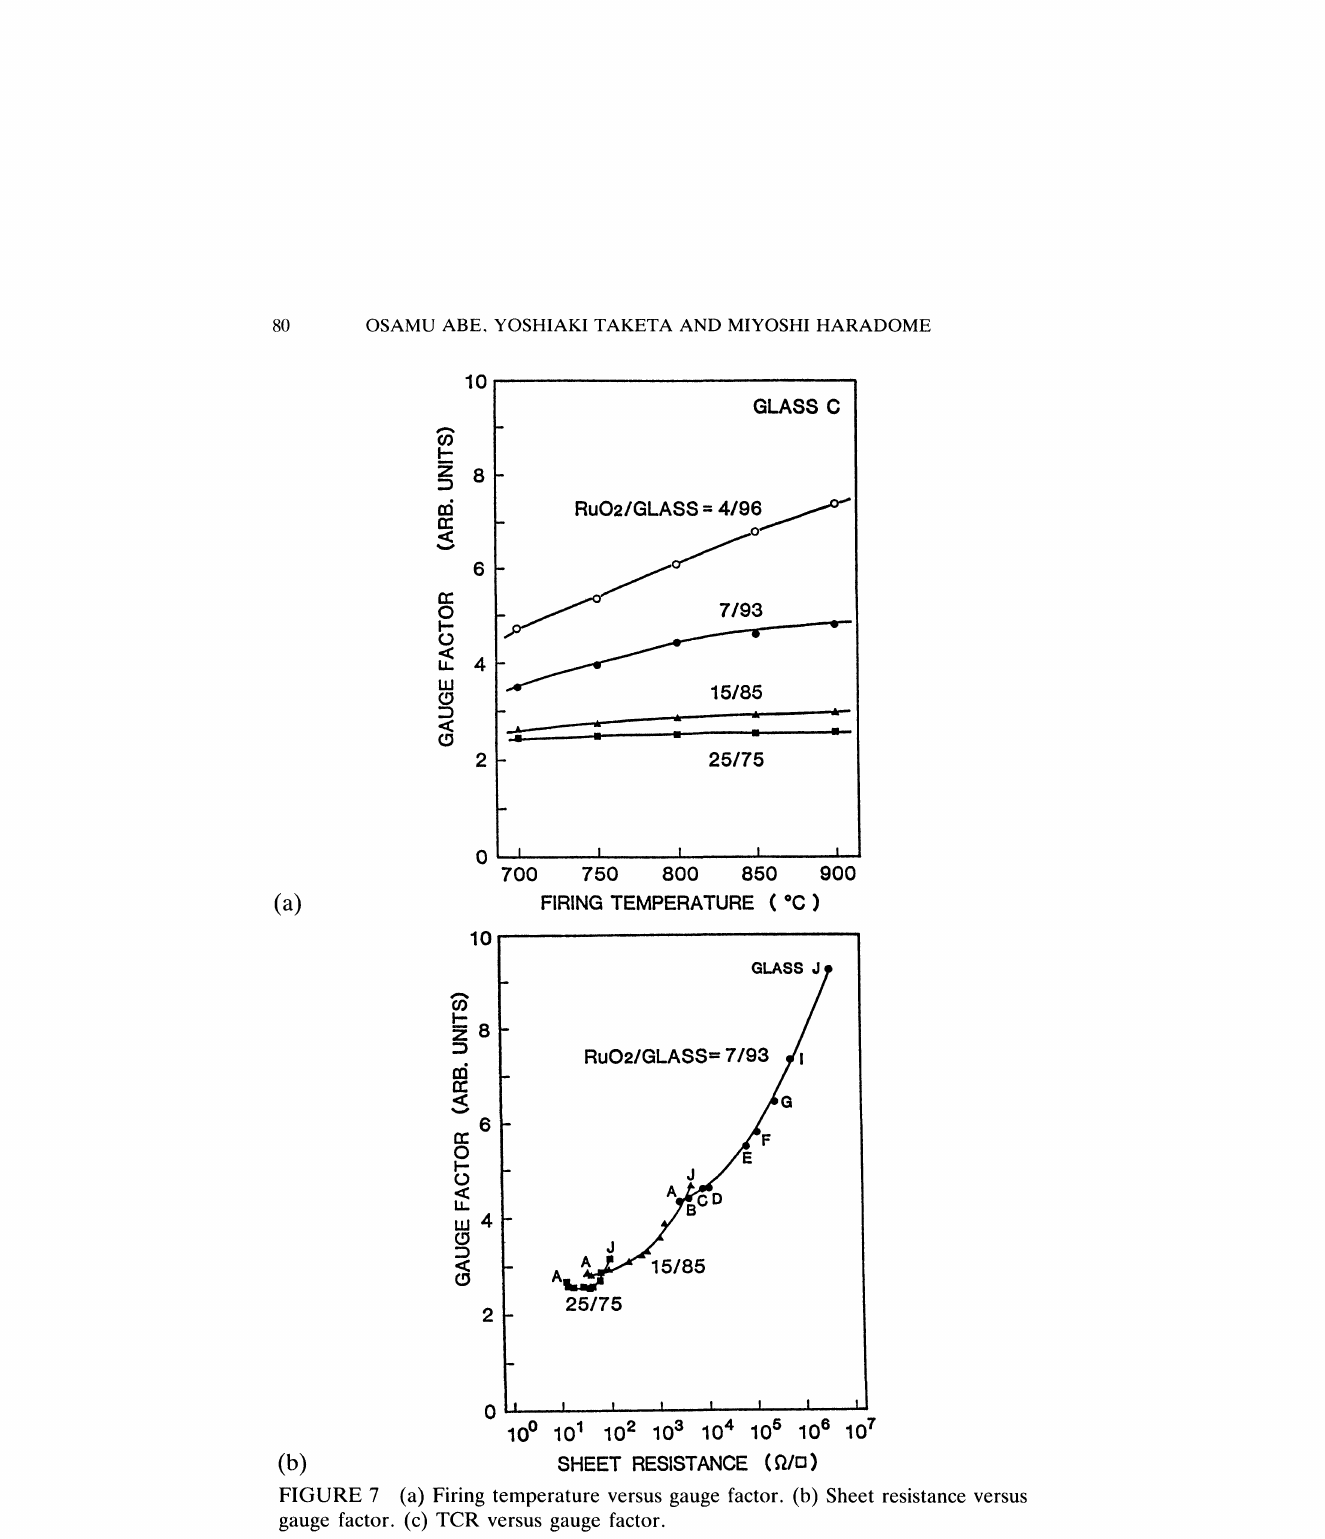
FIGURE 7 (a) Firing temperature versus gauge factor. (b) Sheet resistance versus gauge factor. (c) TCR versus gauge